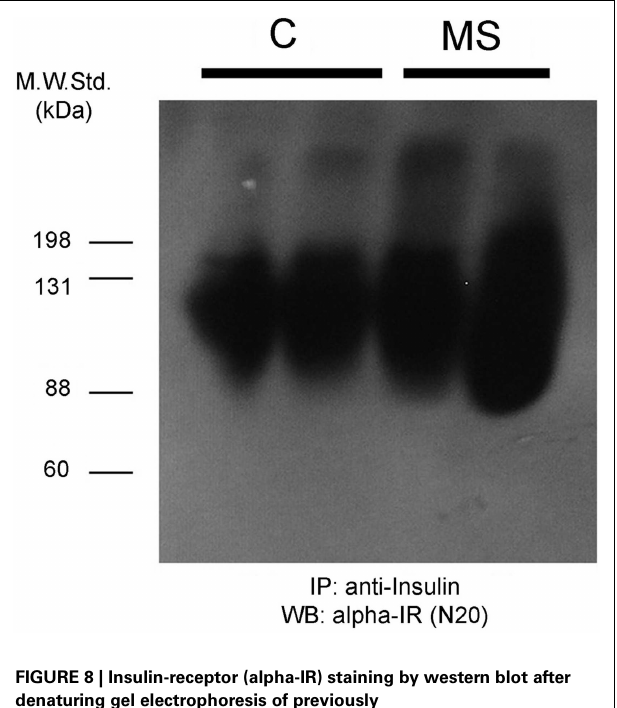
FIGURE 8 | Insulin-receptor (alpha-IR) staining by western blot after denaturing gel electrophoresis of previously insulin-immunoprecipitated plasma samples from two control rats (C) and two animals with metabolic syndrome (MS) . As observed, the insulin-receptor positive bands are broader and more intense in the MS rats.